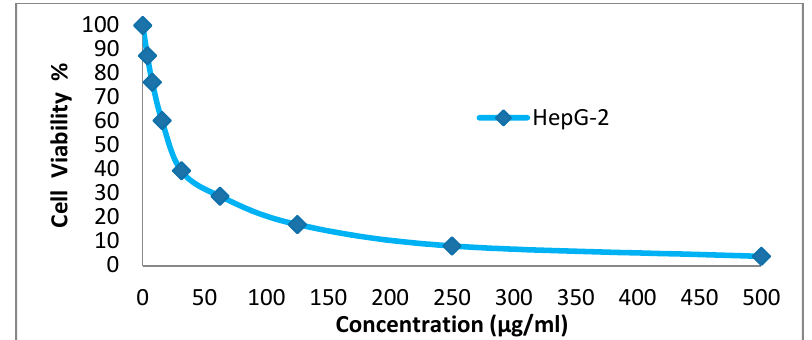
Figure 3. Evaluation of disperse dye 14x on cell line HepG-2.